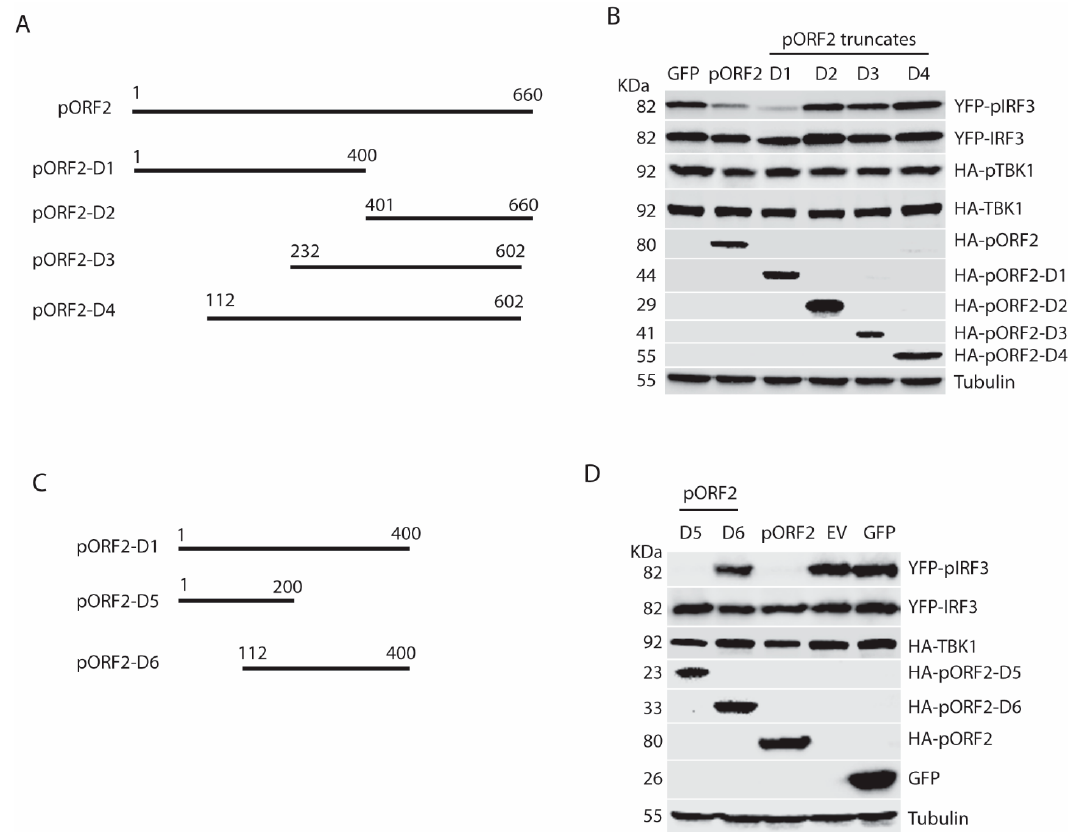
Figure 6. The first 111 aa of the capsid protein is responsible for the inhibition of IRF3 activation. ( A ) Schematic illustration of ORF2 truncation mutants. ( B ) The pORF2-D1 inhibits TBK1-mediated IRF3 activation. The HEK293-IRF3 stable cell line was co-transfected with ORF2 truncations and TBK1 plasmids, and at 36 hpt, the samples were subjected to WB for pIRF3 detection. The molecular weights of the proteins are indicated on the left. ( C ) Schematic illustration of ORF2 truncation mutants D5 and D6. ( D ) The pORF2-D5 inhibits IRF3 activation. Plasmids of ORF2 D5 and D6 were co-transfected to HEK293-IRF3 cells, and at 36 hpt, the samples were subjected to WB for pIRF3 detection.